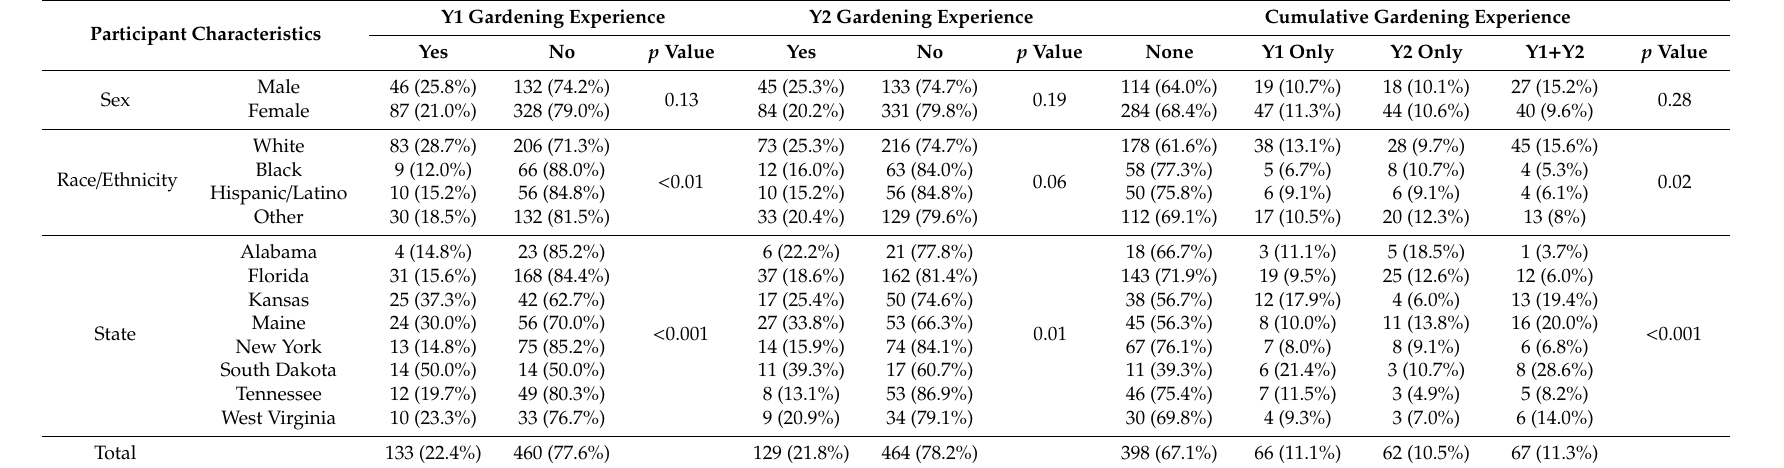
Table 2. Prevalence of college gardening experience by participant characteristics ( N =